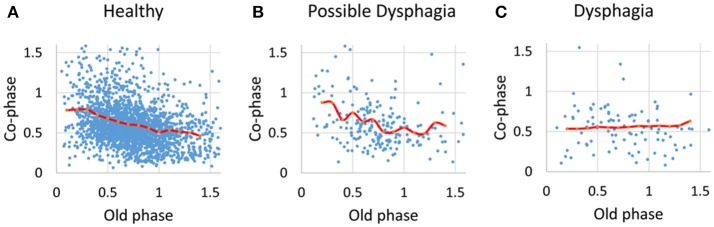
The relationships between old phase and co-phase are plotted for healthy subjects (A), possible dysphagic subjects (B), and dysphagic subjects (C). Red lines indicate the phase-response curves for each subject group calculated by averaging the co-phase within a bin (bin width = 0.1).